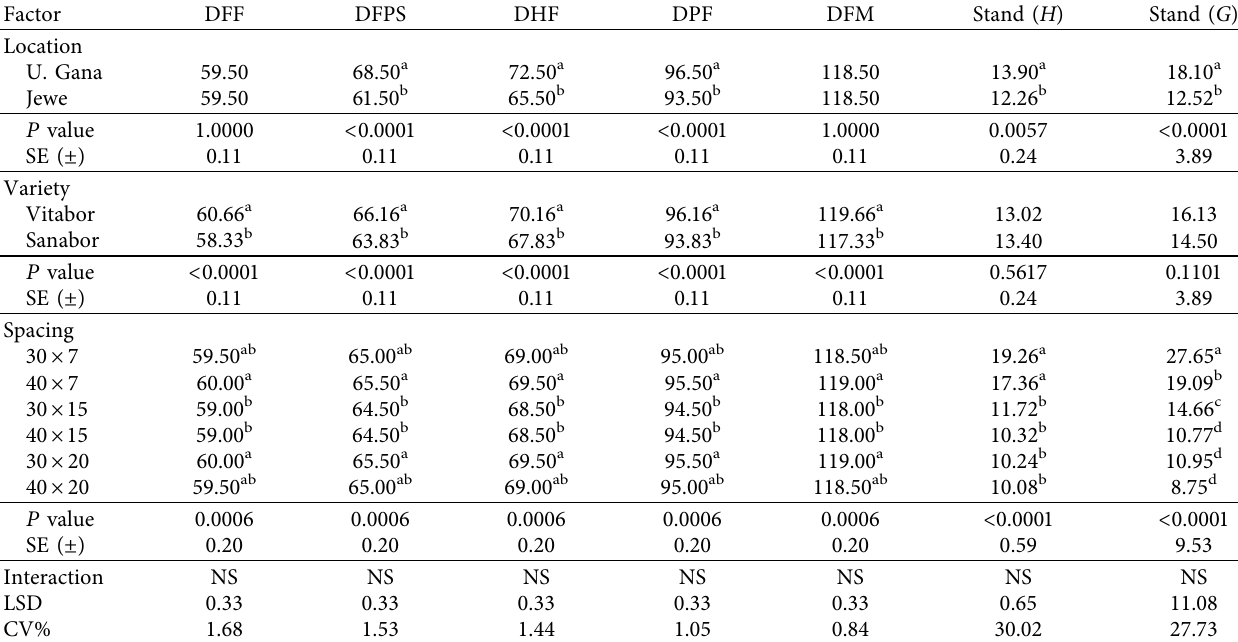
Table 1: Effects of location, variety, and spacing on days to flowering, first pod setting, pod filling, and full maturity. Factor